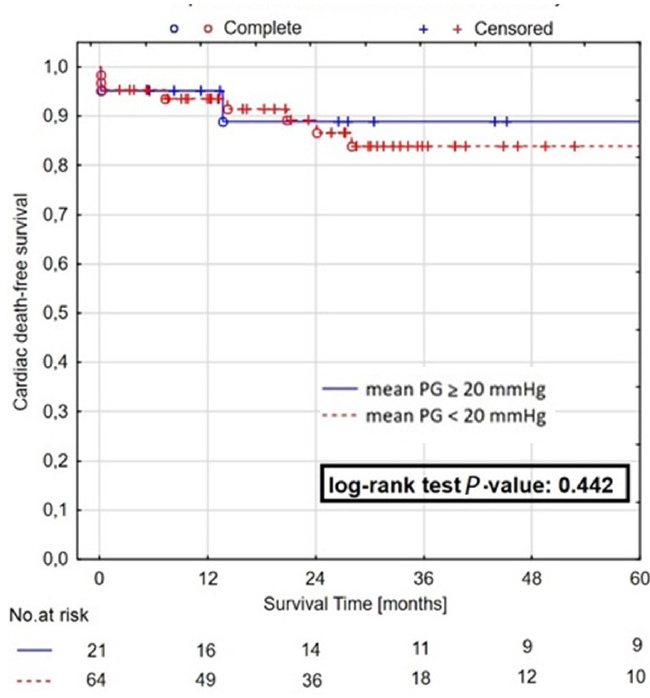
Fig. 3 - Five-year Kaplan-Meier survival curves for cardiac-related death in patients with postoperative pressure gradient (PG) ≥ 20 mmHg and < 20